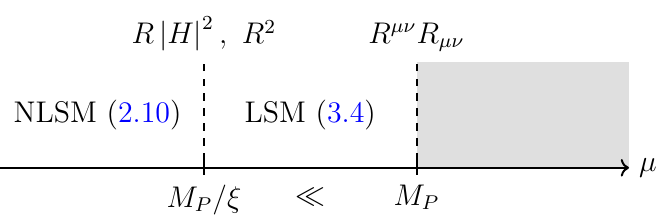
Figure 1 . A schematic picture of the phase diagram of Higgs inflation with ξ (cid:29) 1 , obtained with the help of the large- N limit. In the low energy region, µ < M P /ξ , it is described by the NLSM (2.10) with the Higgs and the conformal mode of the metric being the pions. Once we go to the higher energy region, M P /ξ < µ < M P , it is linearized as eq. (3.4) with the scalaron